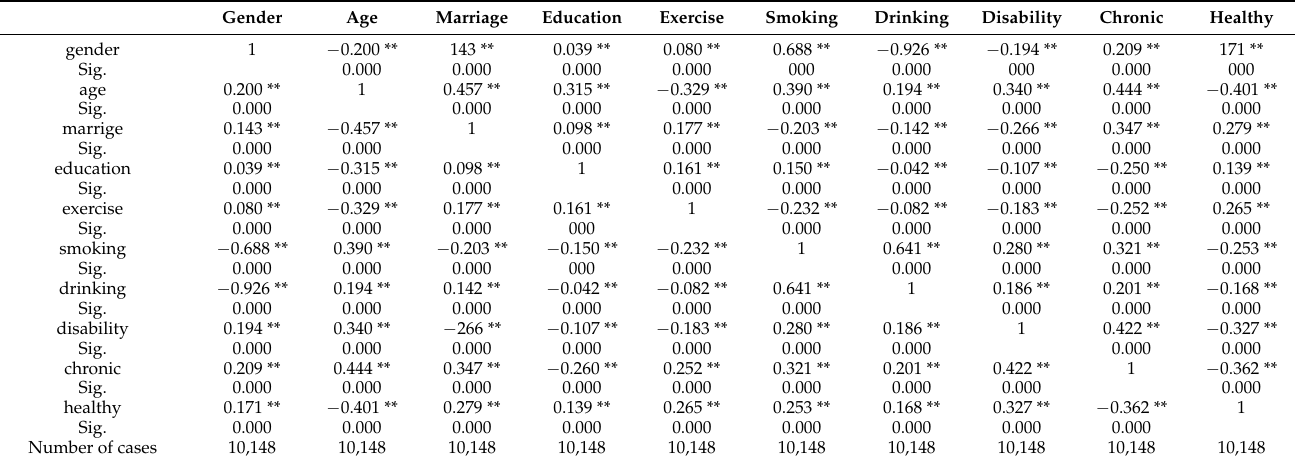
Table A1. Multicollinearity test (Pearson correlation